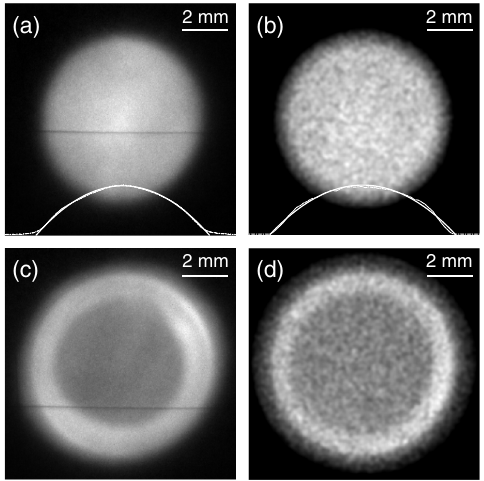
FIG. 2. Measured transverse beam profiles at z ¼ 3 : 0 m from the cathode for (a) a stretched laser pulse and (c) a short laser pulse on the cathode. Corresponding GPT simulation results are shown in (b) and (d). The projection of the beam profiles in (a) and (b) onto one axis (dashed line) are also shown together with the parabolic fitting (solid line).